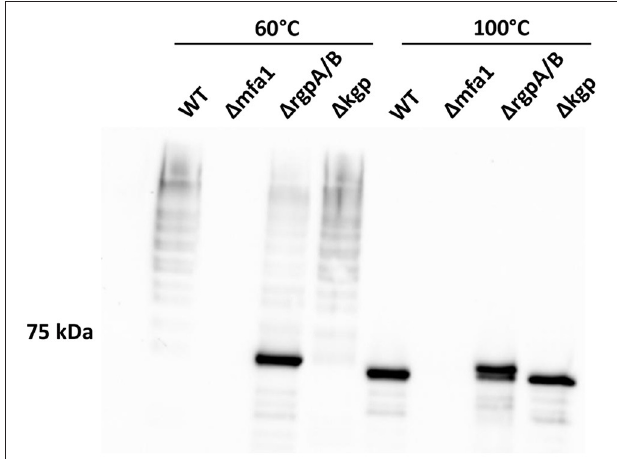
FIGURE 4 | Arginine protease activity is required for Mfa1 polymerization. Whole cell lysates of 33277 WT, 1 mfa1 , 1 rgpA/B , and 1 kgp were treated at 60 ◦ or 100 ◦ C prior to SDS-PAGE followed by immunoblotting with antibodies to Mfa1. Results are representative of 3 biological